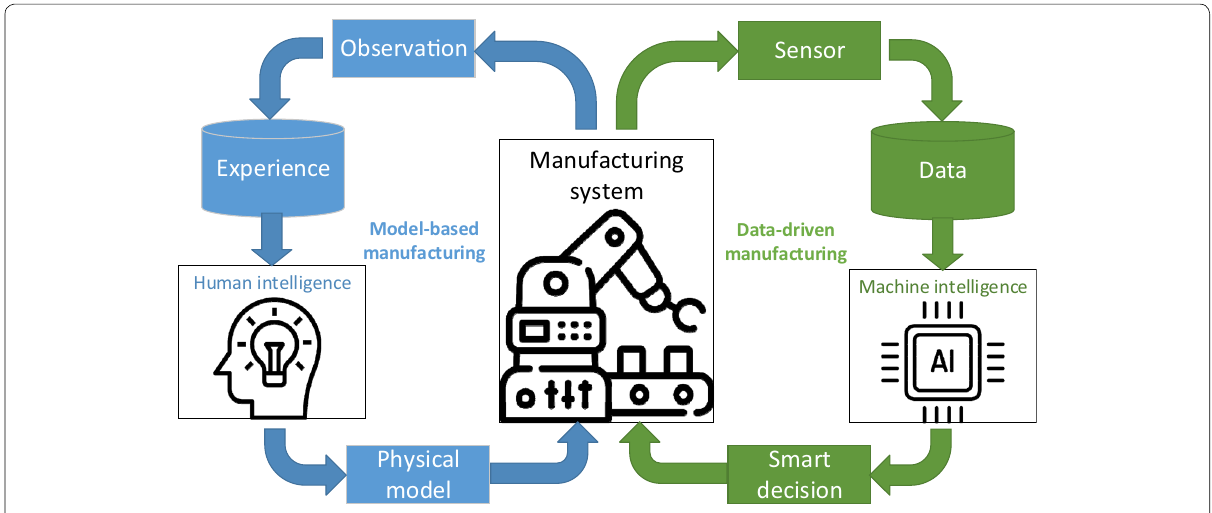
Figure 2 Model-based manufacturing and data-driven